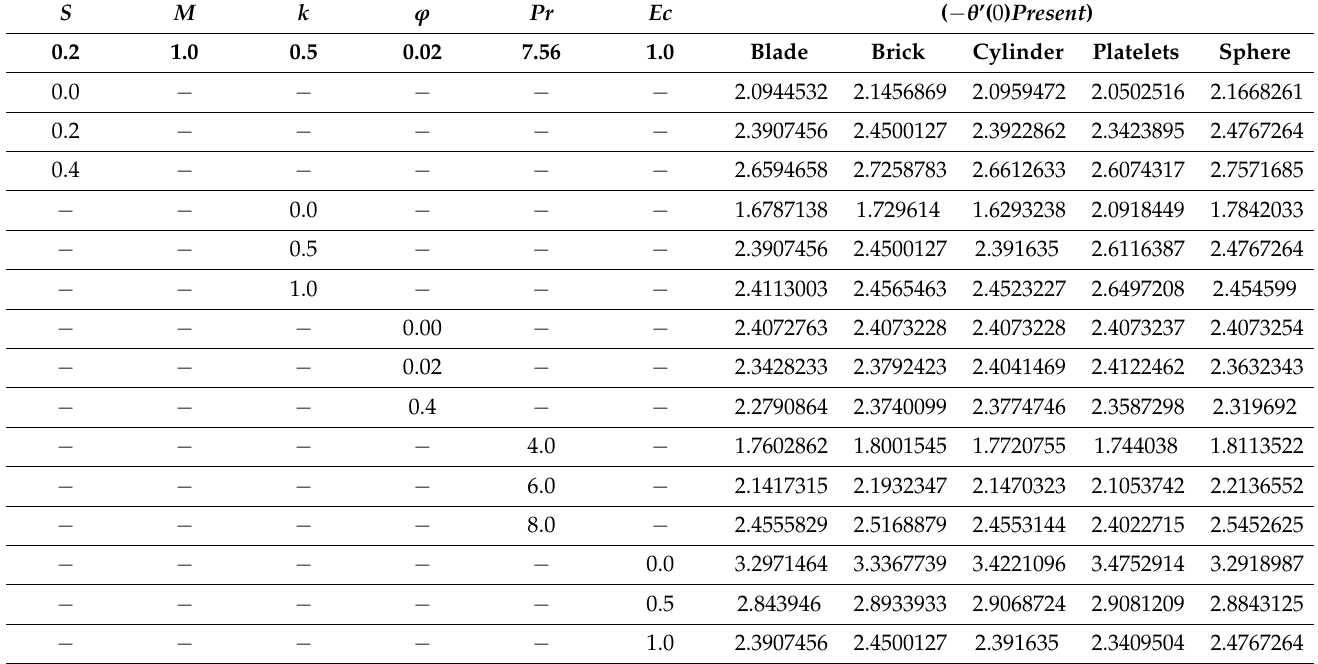
Table 4. The computed results for local Nusselt